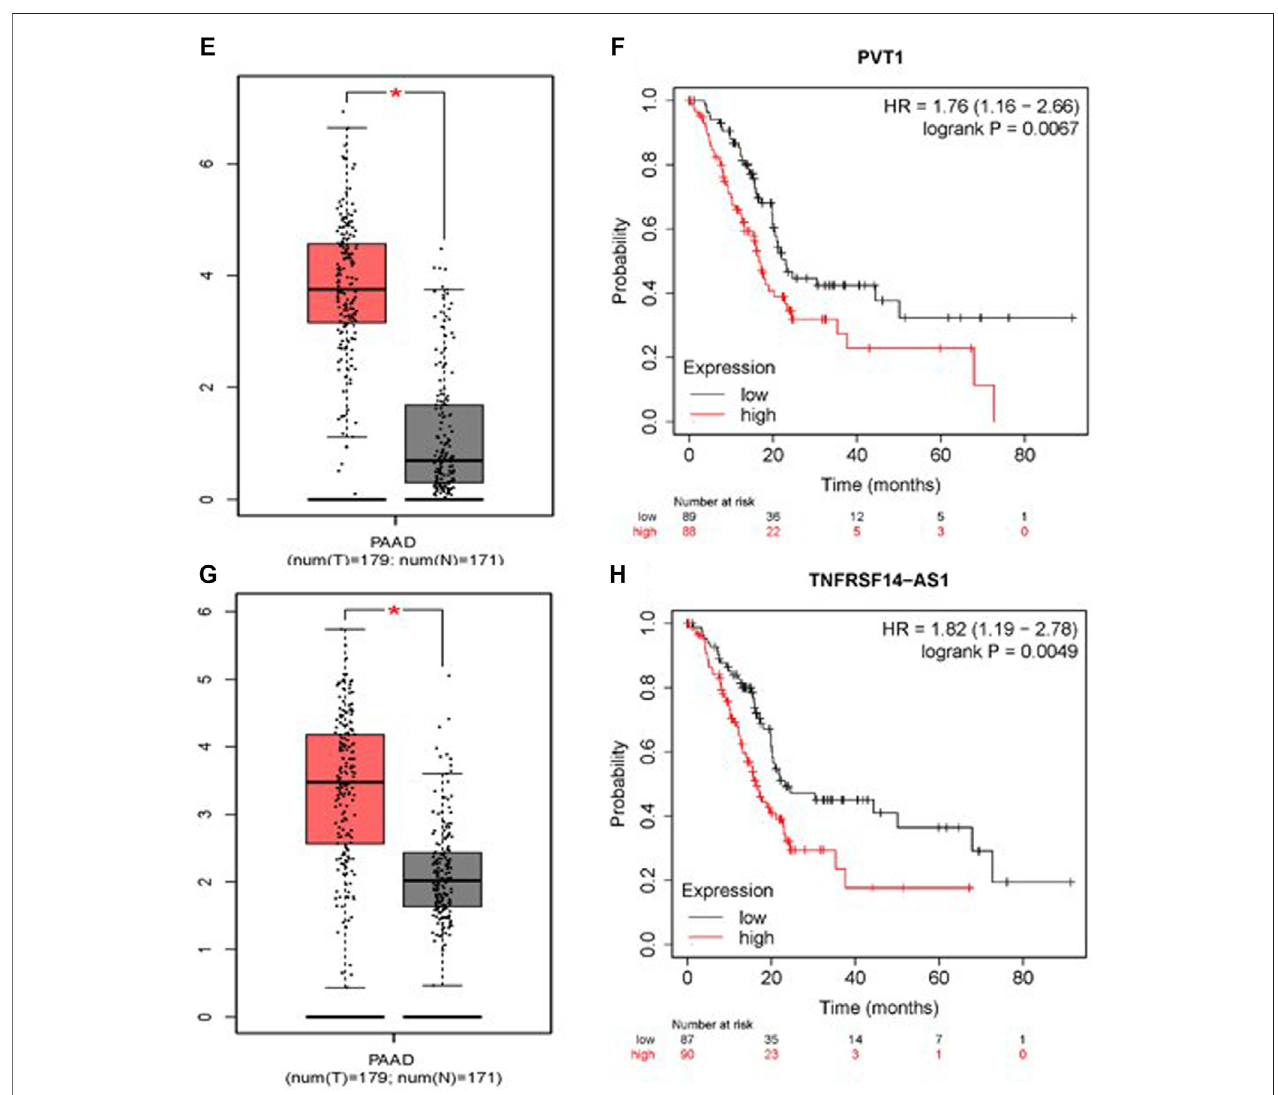
FIGURE 9 | Expression analysis and survival analysis for upstream lncRNAs of hsa-miR-15a-5p in PAAD. Prediction of lncRNA by miRNA, and differential expression and prognostic analysis suggested that four lncRNAs have prognostic value. (A,C,E,G) Expression of LINC00511 (A) , LINC01578 (C) , PVT1 (E) , and TNFRSF14-AS1 (G) in TCGA PAAD compared with “ TCGA normal ” or “ TCGA and GTEx normal ” data. (B,D,F,H) Overall survival (OS) analysis for LINC00511 (A) , LINC01578 (C) , PVT1 (E) , and TNFRSF14-AS1 (G) in PAAD. * p value < 0.05.